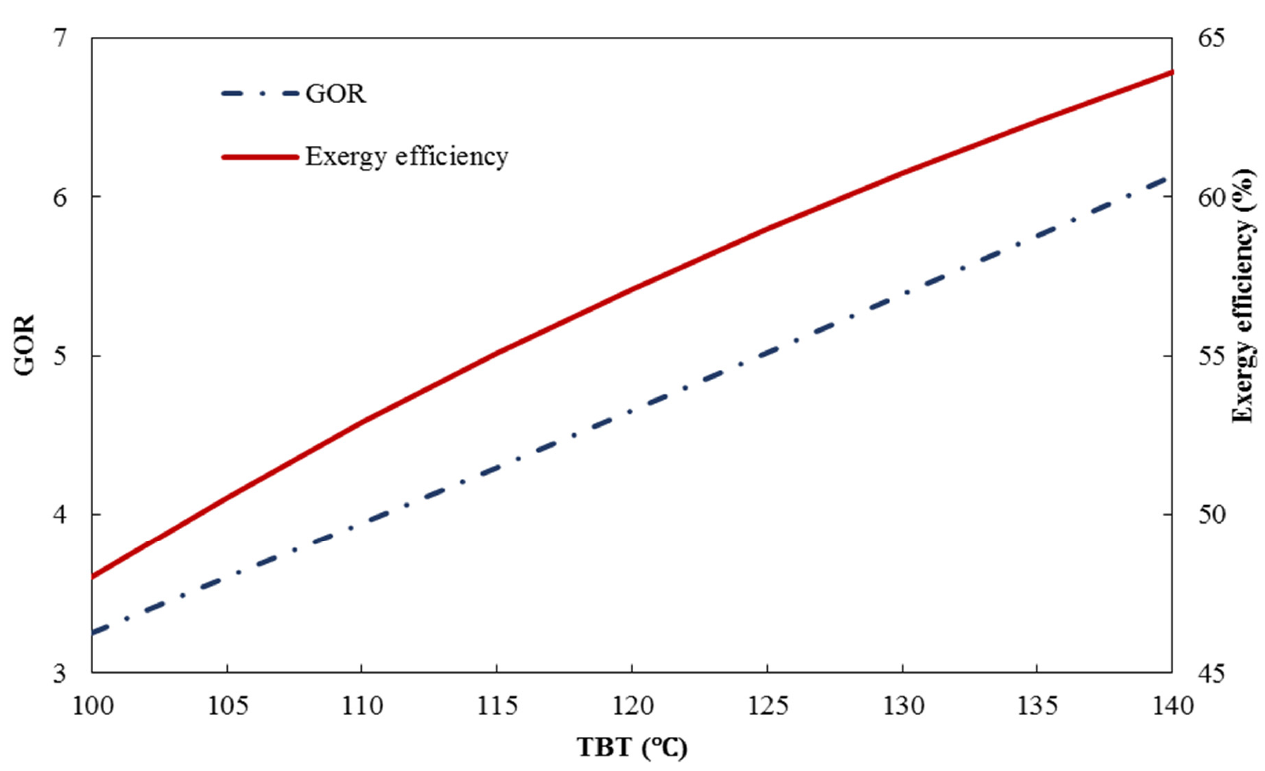
Figure 8. Variations of GOR and exergy efficiency in terms of top brine temperature .